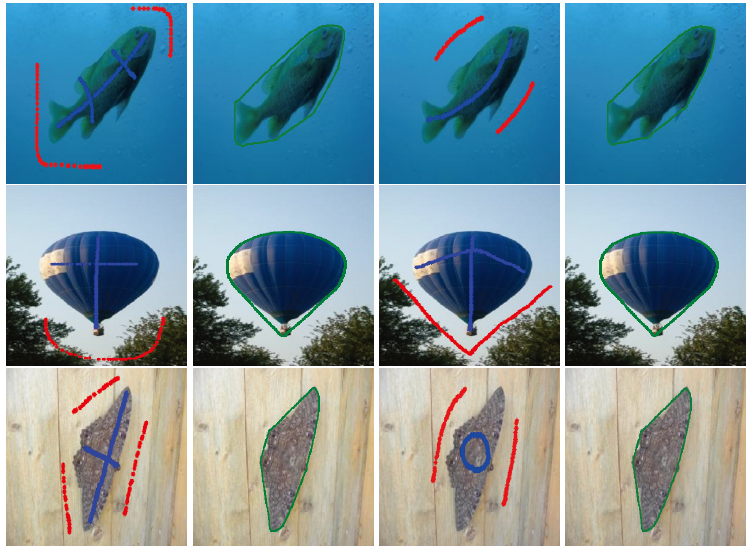
Figure 8. The robustness tests of different initial contours on our image segmentation methods with some original images shown in Figure 3. In each row of the figure, the first two columns and the last two columns show the original images with given initial contours and our corresponding image segmentation results,